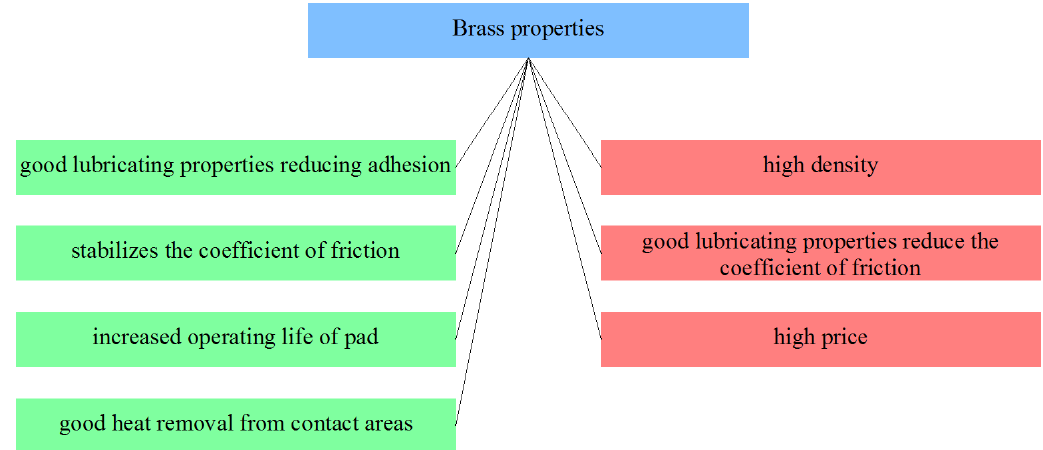
Figure 25: Selected brass composites properties from the point of view of applicability in friction